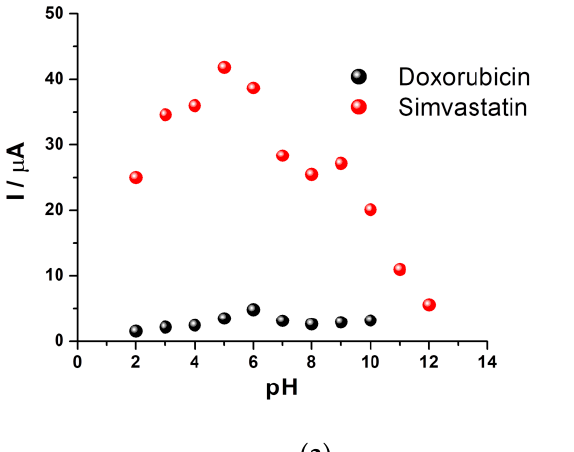
Figure 3. Proposed global mechanism for the electrochemical oxidation of DOX. As was described for the case of DOX, a higher intensity of the analytical signal of SMV was observed at lower values of pH, with the best results in the range of 5–6 (Figure 2a; red). Like in the case of DOX, no electrochemical oxidation of SMV was observed when basic electrolytes were used, leading to the presumption that the mechanism for SMV also involves the participation of protons. In the range of pH 2.0–12.0, the oxidation current increased with the decrease of pH at first and reached a maximum value at about pH 5. Further decrease of pH determined a slow decrease of the oxidation current, thus the effect of pH on the oxidation peak current presented a different type of variation compared with DOX. Regarding the influence of the pH on the oxidation potential of SMV, a slight increase of its value was observed with the variation of pH (Figure 2b; red). Thus, in the range of pH 2–12, the peak potential negatively shifted with the decrease of the pH value, without following a linear dependence on the whole pH range tested but only on small domains (Figure 2b; red). The abnormal variation of the peak potential with pH might arise from the coexistence of SMV and its hydrolyzed product since this analyte might be hydrolyzed at higher pH values, as it was already observed before in other papers [22]. Since for SMV the variation of the peak potential is smaller but still noticeable, it was assumed that an equal number of electrons and protons took part in the oxidation of SMV. (Figure 4). The chemical structure of SMV contains a β -hydroxy-lactone which undergoes a ring opening process during oxidation, as it has been previously observed [23].